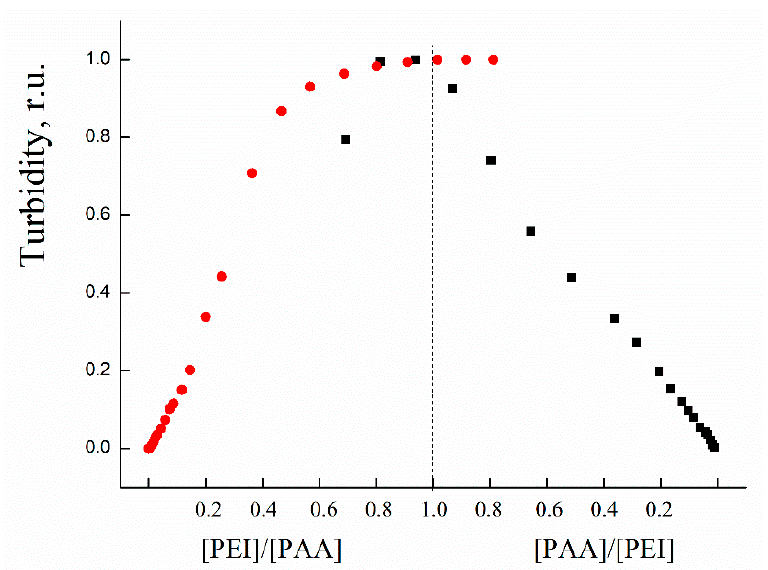
Figure 1. The dependence of relative turbidity at pH = 6 upon [PEI]/[PAA] ratio (curve 1 red) and [PAA]/[PEI] ratio (curve 2 black).